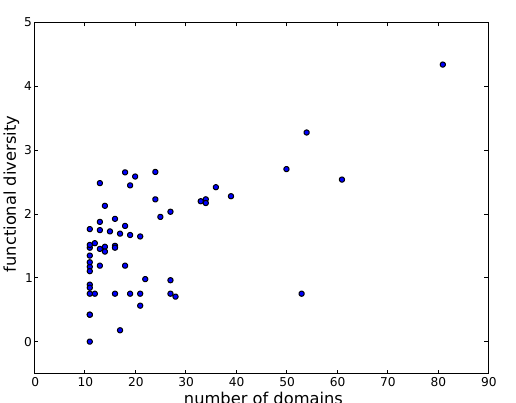
Figure 4: Scatter showing number of domains against functional diversity (depth weighting of 0.75)